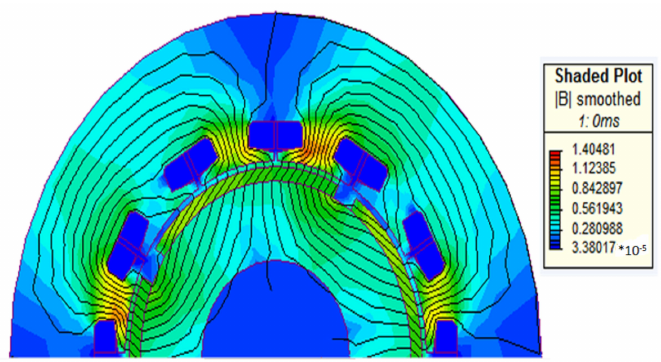
Figure 9. Flux plots in symmetrical